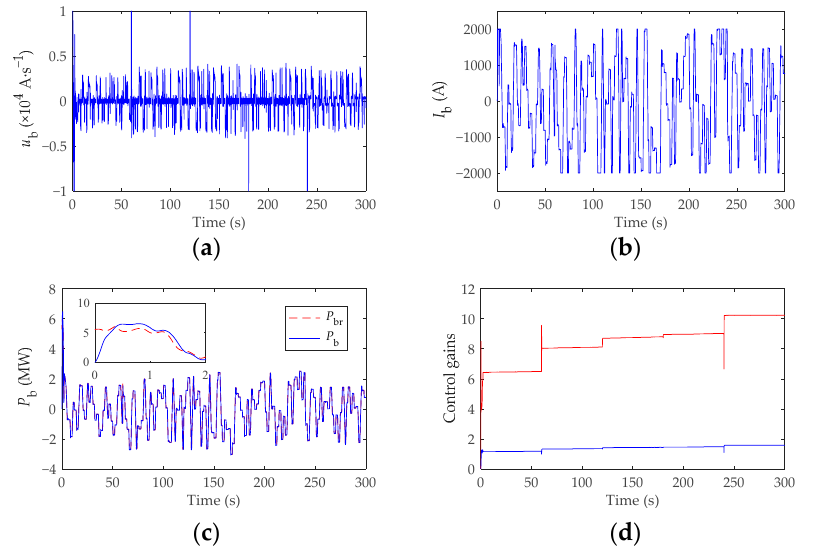
Figure 11. Results of BESS ( a ) Control input u b . ( b ) Battery current I b . ( c ) Tracking of the power output P b . ( d ) Control gains k b 1 and k b 2 .